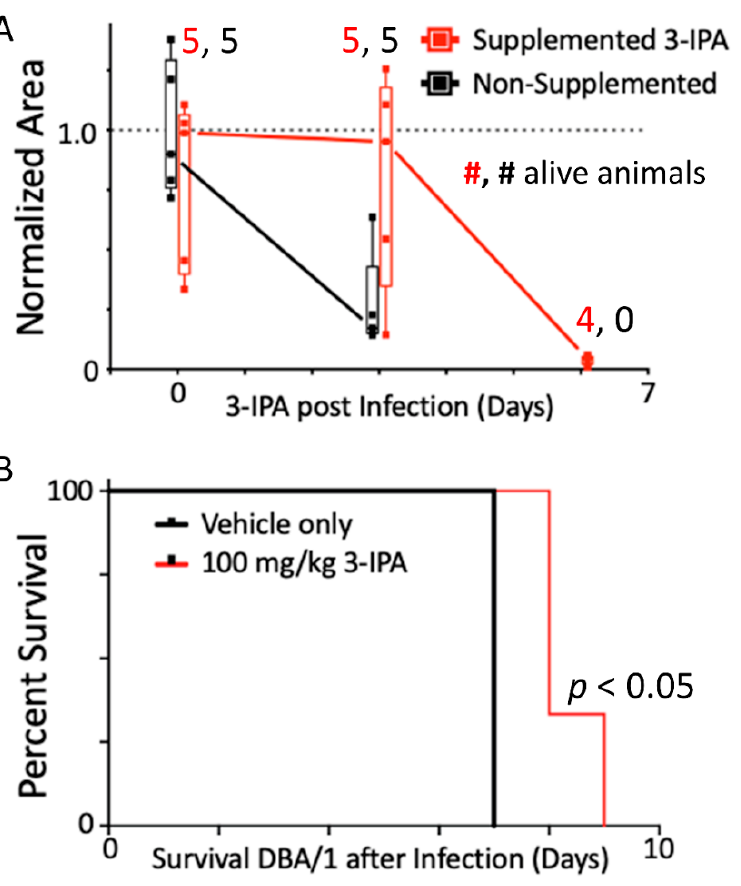
Figure 3. 3-IPA supplementation helped in maintaining its plasma levels and delayed death in DBA1 mice infected with LCMV Cl13. ( A ) 3-IPA was measured in plasma post-LCMV Cl13 infection in supplemented (100 mg/Kg/day in the drinking water, 24 h prior to infection) and non-supplemented mice. Data were normalized using the non-supplemented cohort at day 0. The number of alive animals per group at each time point is indicated. ( B ) Survival of 3-IPA supplemented mice after LCMV Cl13 infection. Mice received either 100 mg/Kg/day of orally supplemented 3-IPA ( n = 3) or vehicle alone ( n = 4) daily from one day prior to infection. Drinking water for both groups contained powdered grape crush (2.3 g/L).